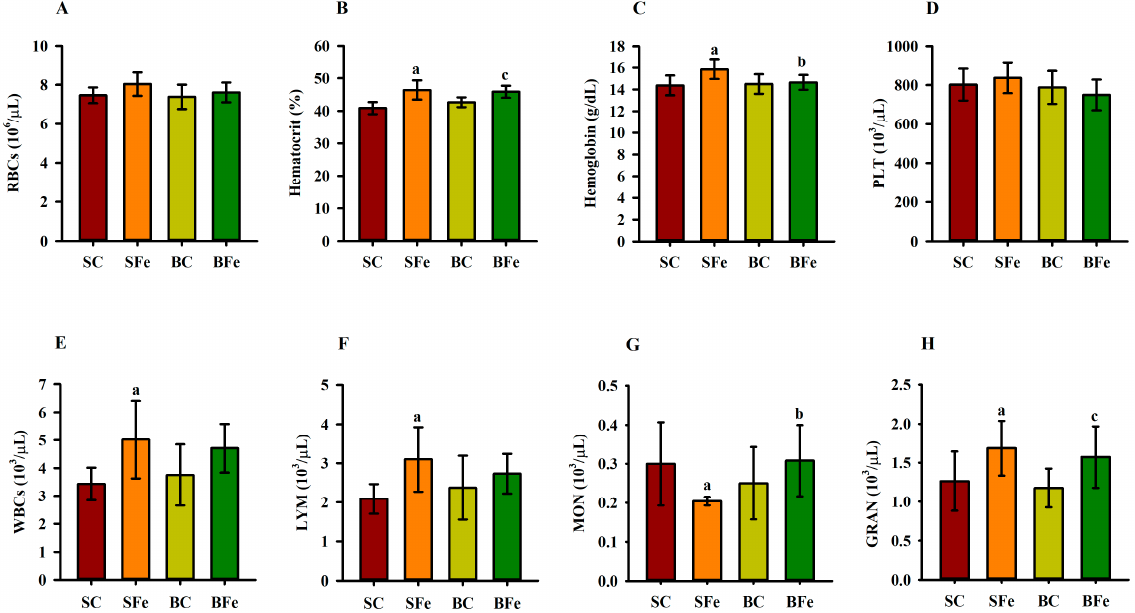
Figure 4. Hematological parameters of rats treated or not with a high dose of FeSO 4 and diets added with either soybean oil or buriti oil. Red blood cell ( A ), hematocrit ( B ), hemoglobin ( C ), platelet ( D ), white blood cell ( E ), lymphocyte ( F ), monocyte ( G ), and granulocyte ( H ) counts. SC = control group fed a diet containing soybean oil and gavage with saline solution; BC = control group fed a diet containing buriti oil and gavage with saline solution; SFe = group fed a diet containing soybean oil and gavage with a high-dose FeSO 4 ; BFe = group fed a diet containing buriti oil and gavage with a high-dose FeSO 4 . RBCs = red blood cells; PLT = platelets; WBCs = white blood cells; LYM = lymphocytes; MON = monocytes; GRAN = granulocytes. a Represents a significant difference compared with the SC; b Represents a significant difference compared with the SFe; c Represents a significant difference compared with the BC. Values in the vertical bars are mean ± SD of each rat group (Student’s t -test, p ≤ 0.05; n = 8 rats/group).